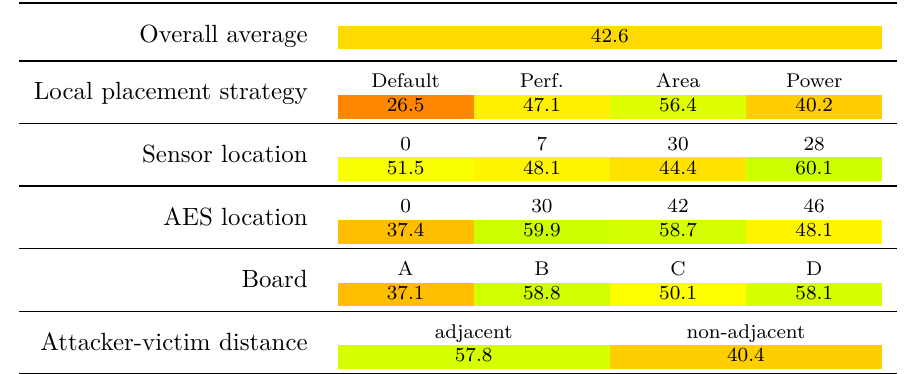
Table 2: Averages over the minimum amounts of traces ( × 1 , 000) required for a success- ful attack across all other dimensions and both original and recompiled design, when considering only specific design space